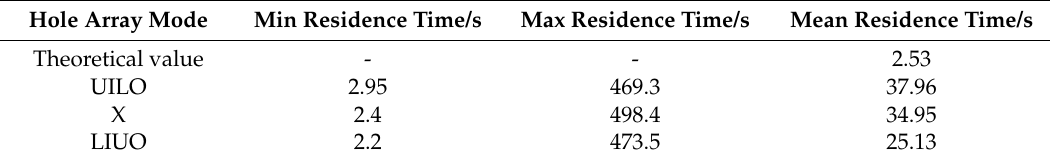
Figure 9. Movement of the inclusions in MHDB. Table 2. Statistics for the residence time of the inclusions in MHDB in different modes.